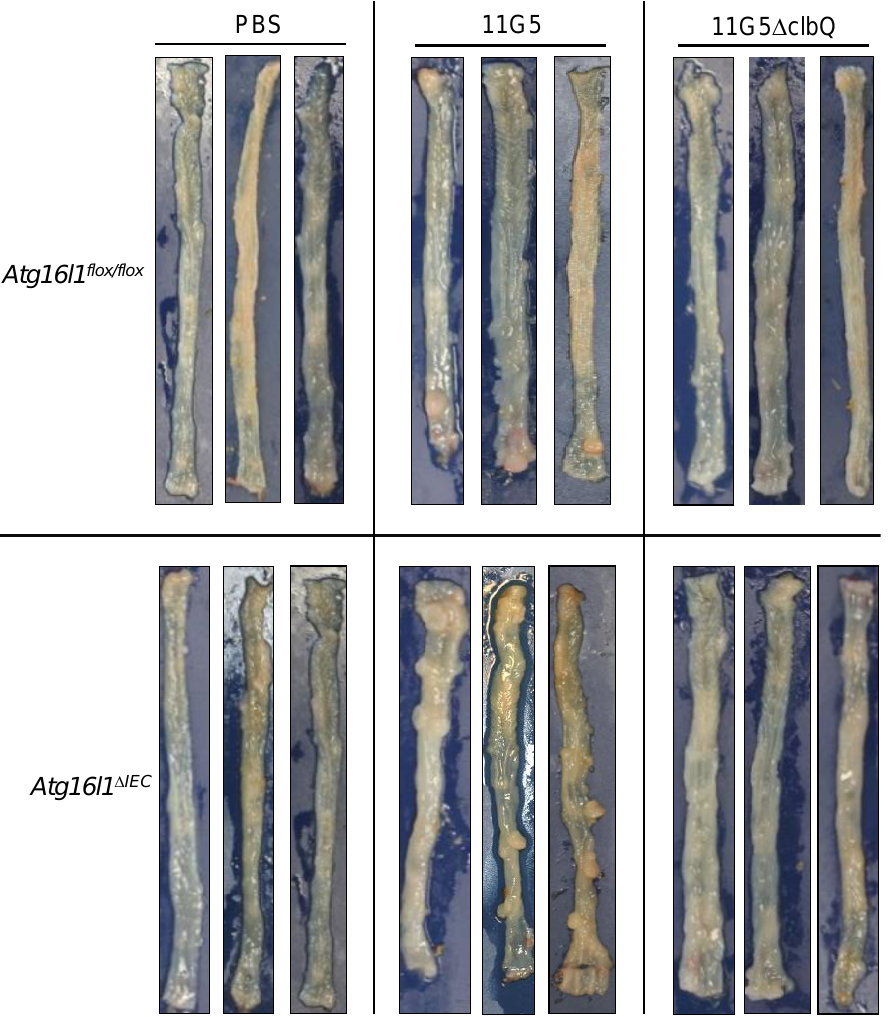
Figure 2. CoPEC infection induces colon tumorigenesis in a mouse model of chronic DSS treatment, and this is further enhanced by autophagy deficiency in IECs. Atg16l1 flox/flox and Atg16l1 ∆IEC mice were treated with streptomycin for 3 days and then received water for 24 h before being orally administered (day 0) with PBS or with 10 9 colony-forming units of 11G5 bacteria or the mutant 11G5∆clbQ. Seven days later, the mice were subjected to 12 cycles of DSS treatment. Representative photos of the colons taken at the sacrifice were shown. The images are representatives of N = 10 mice/group for +PBS and 11G5-infected conditions, and N = 6 mice/group for 11G5∆clbQ-infected condition.